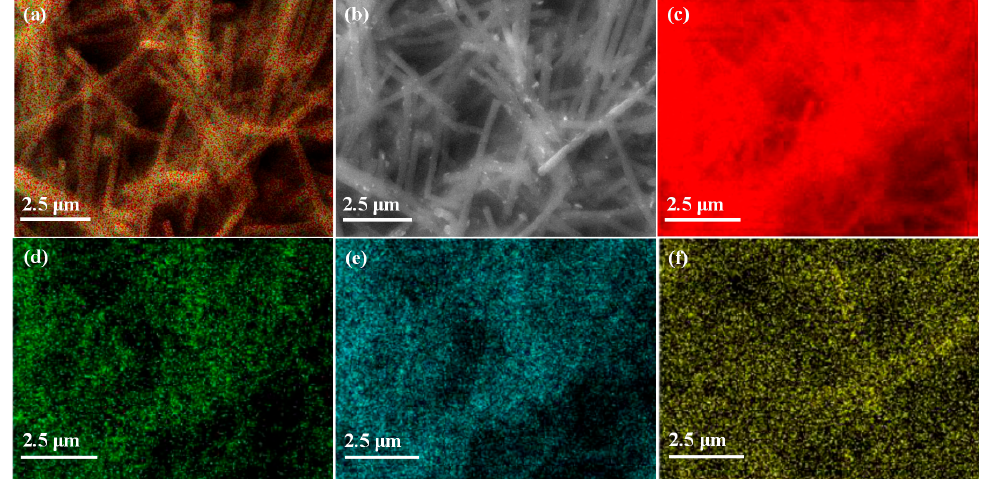
Figure 2. Elemental mapping and distribution of all elements. ( a ), Electron microscopy image ( b ), and images of each element: ( c ) C, ( d ) N, ( e ) O, and ( f ) Pd in Pd/CNFs. The quantitative EDX analysis gave the following molar ratios: Pd (1.0% ± 0.4%), C (80.8% ± 1.5%), N (14.7% ± 0.3%), O (3.5% ± 1.1%), and the following weight ratios: 72.8 ± 3.6 wt% of C, 15.1 ± 0.7 wt% of N, 3.8 ± 1.08 wt% of O, 8.3 ± 3.2 wt% of Pd. Elemental mapping (Figure 2) confirmed that